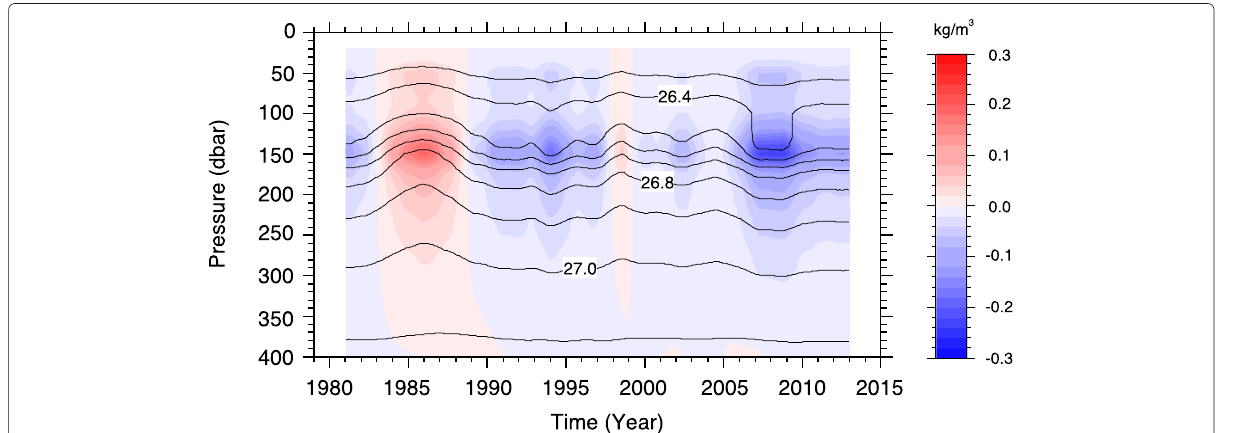
Fig. 17 Time-pressure diagram of the calculated variation in the potential density ( σ θ , contours) due to the baroclinic Rossby wave modes ( n = 1, 2, 3, and 4) in the top 400dbar forced by the wind stress and the calculated anomaly from the mean potential density profile (kgm − 3 , color shades). The contour interval is 0.1kgm − 3 . Smoothing was performed using a 49-month running mean